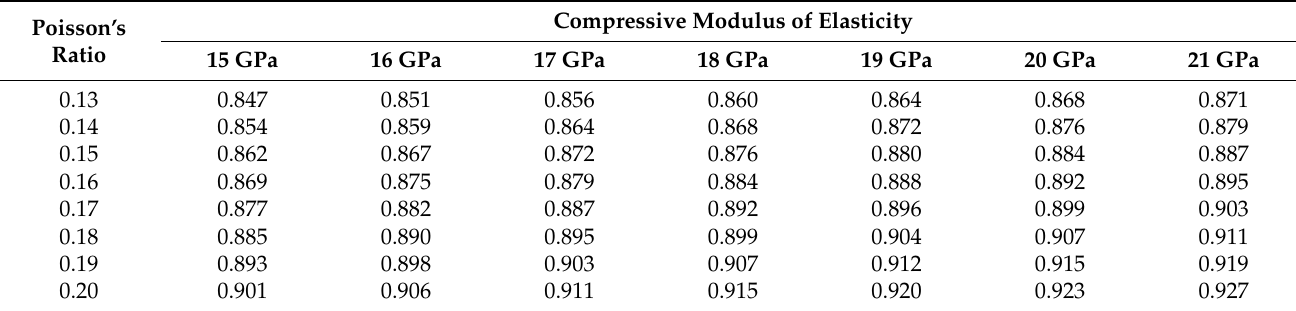
Table 8. Tensile stress corresponding to different Poisson’s ratios and compressive elastic moduli of thick cushion layer cement self-leveling